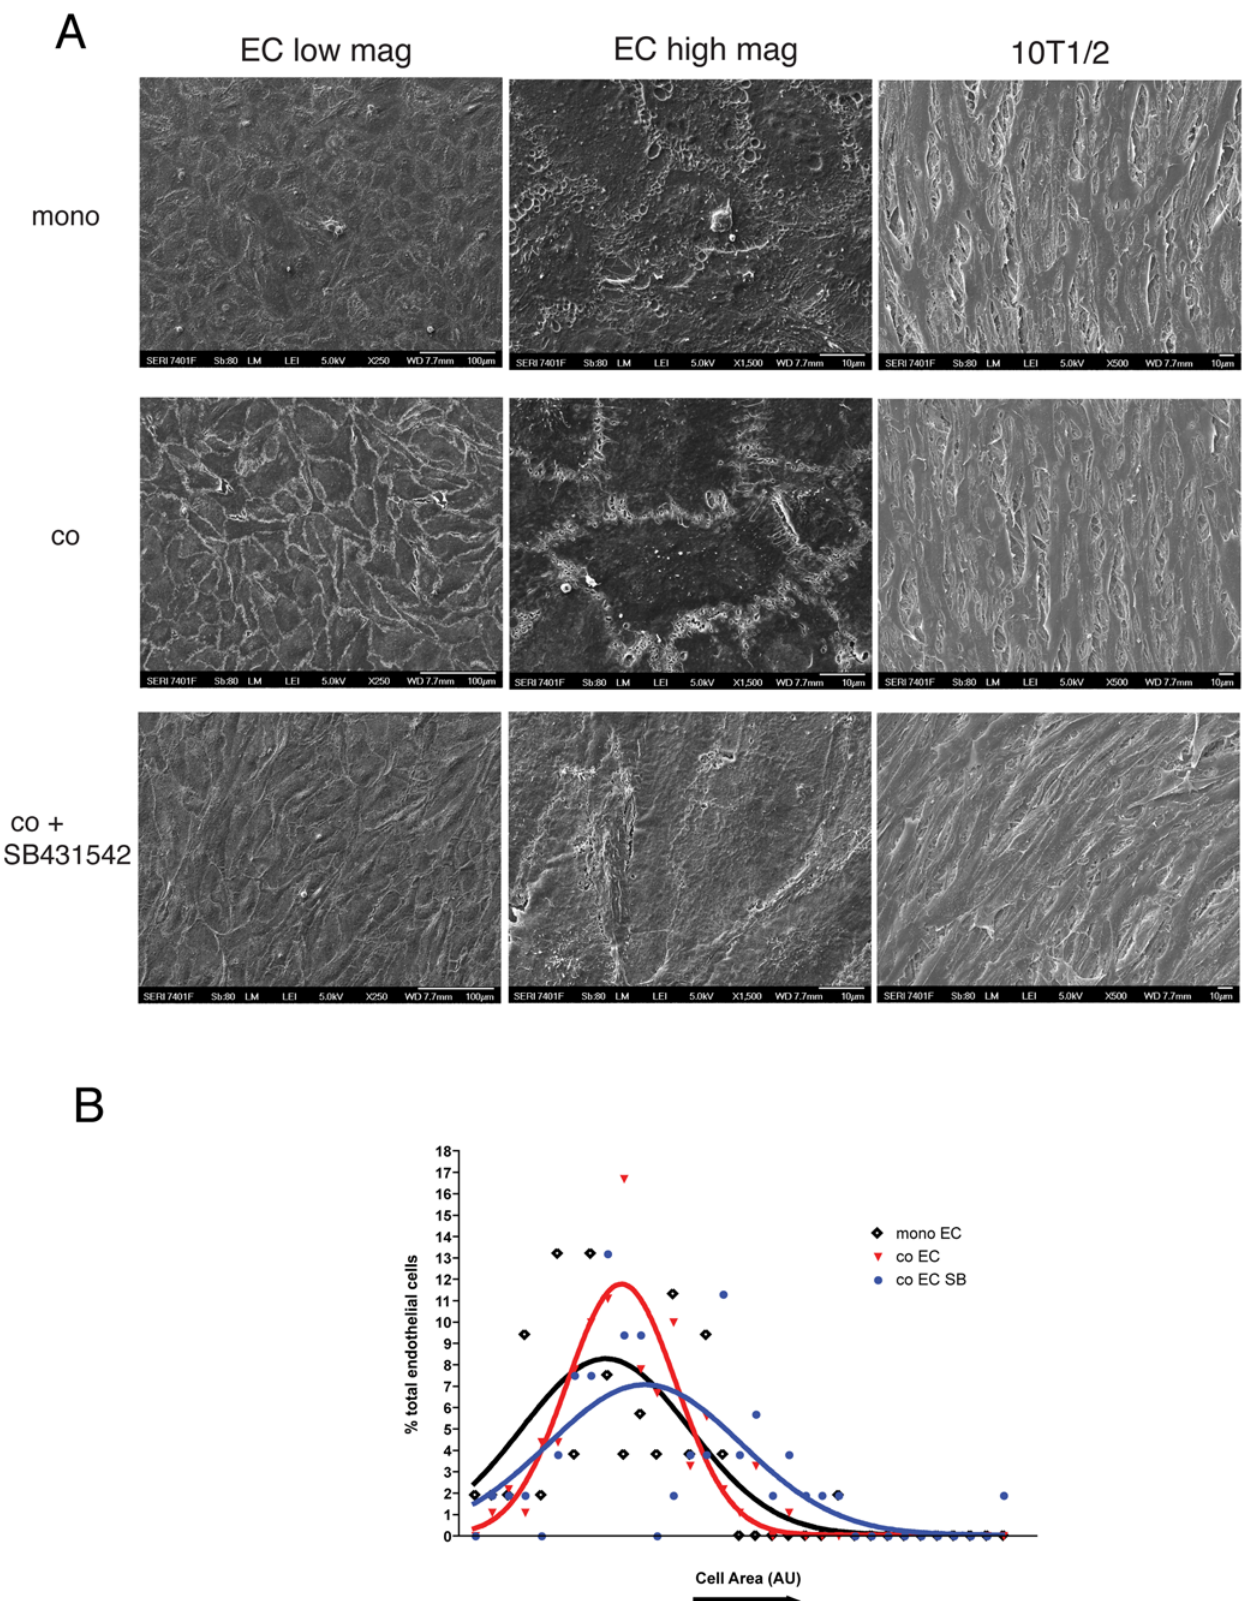
Figure 5. Inhibition of TGF- b decreases endothelial barrier function in vitro. (A) SEM analysis demonstrated a characteristic endothelial cobblestone morphology in EC monocultures. Co-culture enhanced the association between adjacent cells, which was reversed with addition of SB- 431542. Scale bars=100 m m (left panel); 10 m m (right panel). Cell size was calculated by tracing individual ECs using ImageJ. Morphology of 10T1/2 PLoS ONE |